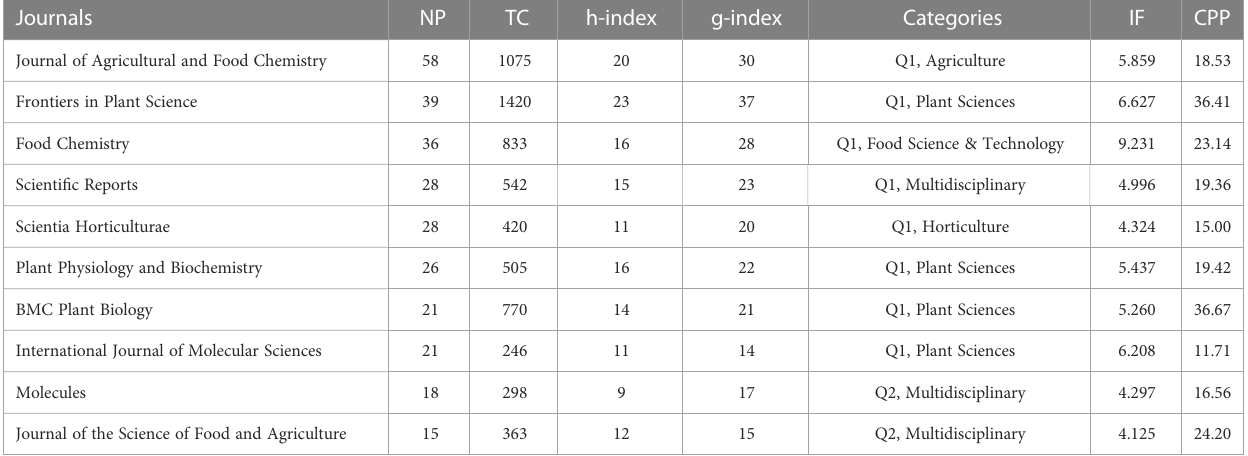
TABLE 2 Top ten produced journals with applied information (sorted by NP).